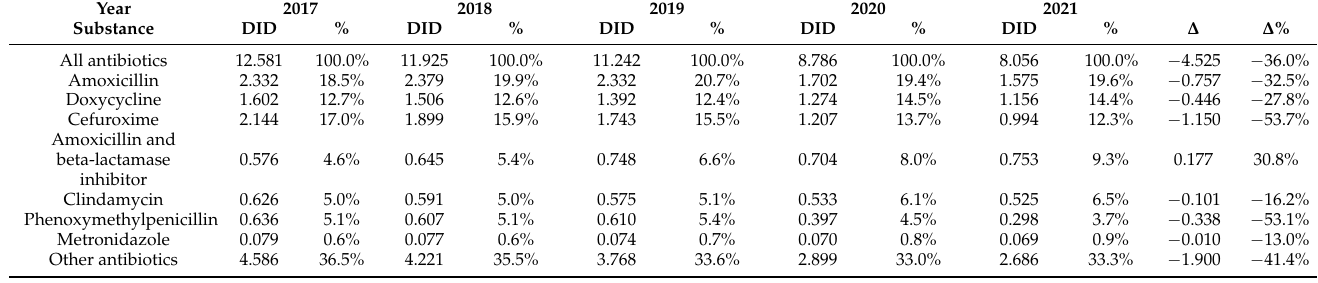
Table 2. Prescription of systemic antibiotics in primary care during 2017 to 2021 in DID. Abbreviations: DID, defined daily doses per 1000 statutory health-insured persons per day; %, share of all prescribed antibiotics; ∆ , difference between 2021 and 2017 DID; ∆ %, percentage difference between 2021 and 2017 DID.